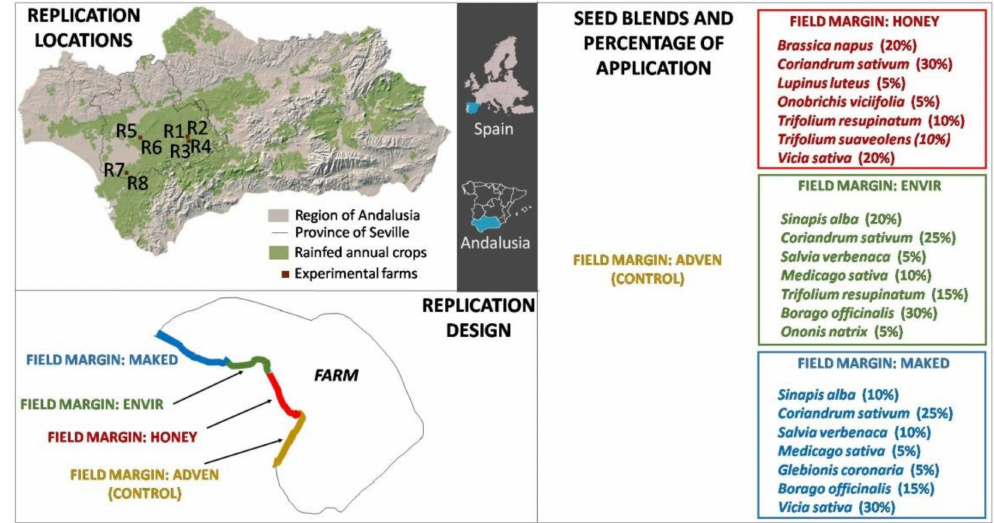
Figure 1. Geographical locations of the eight replicates studied. Scheme of each replication and seed blends and percentage of application in each MFM